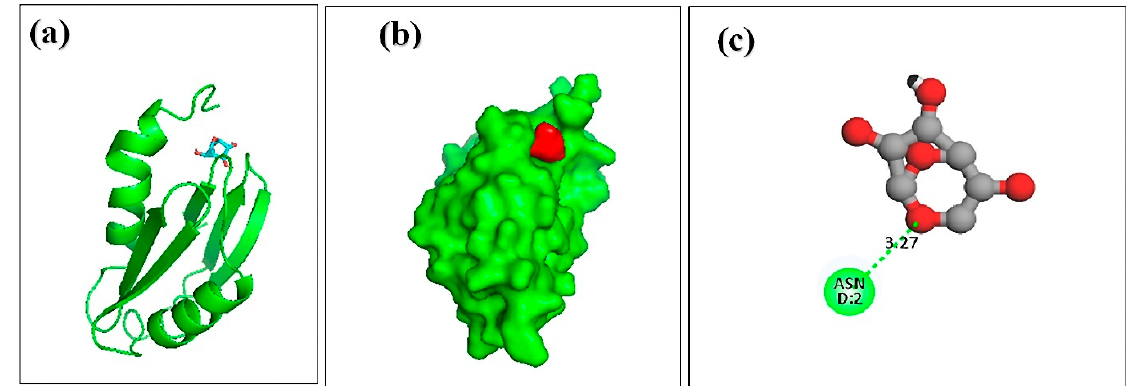
Figure 5. Docking simulation between the spike receptor ‐ binding domain of hemolysin II (protein) and beta. ‐ D ‐ glucopyranose,1,6 ‐ anhydro, where ( a ) shows the cartoon view, ( b ) surface view, and ( c ) 2D view.